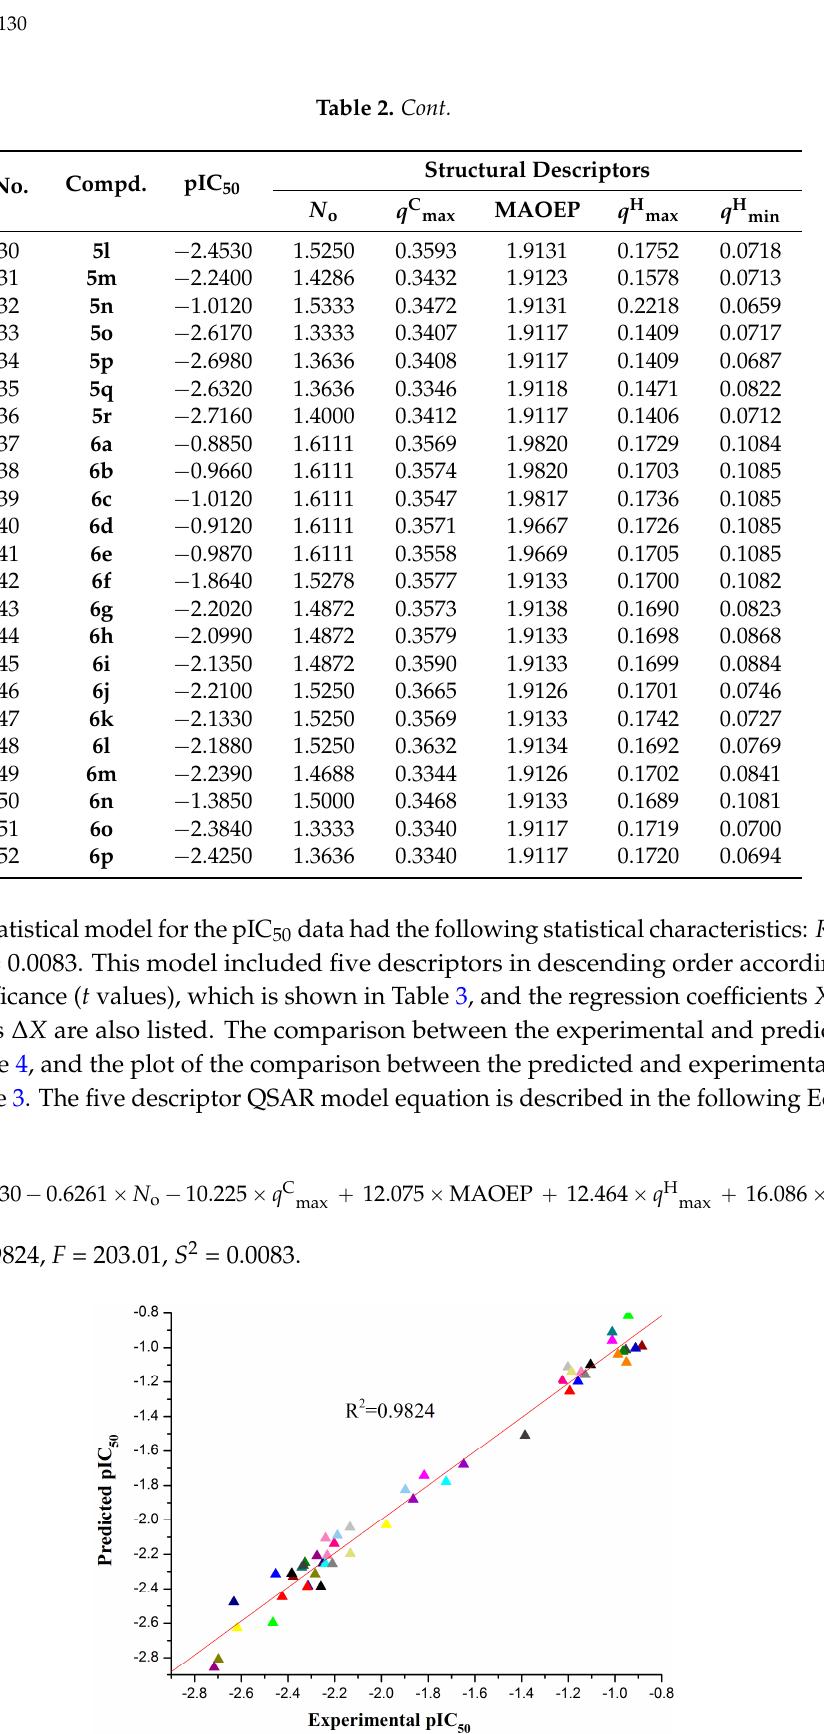
Figure 4. Optimized structures and HOMO energy maps for compounds 5c , f from the DFT calculations of Gaussian 03W. The green parts represent positive molecular orbitals, and the red parts represent negative molecular orbitals. Table 3. The best five-descriptor model. Descriptor No.